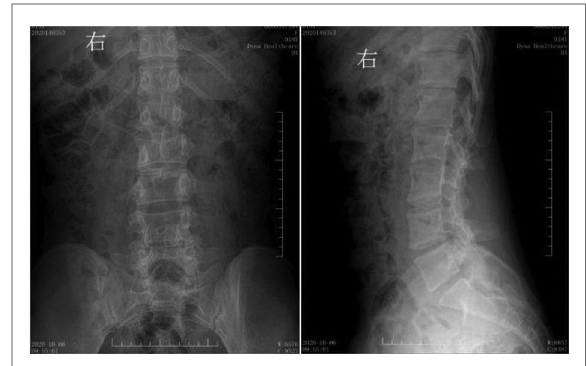
FIGURE 7 Postoperative digital radiography. The spine was bi fi da, with no display of some lumbar spinous processes.